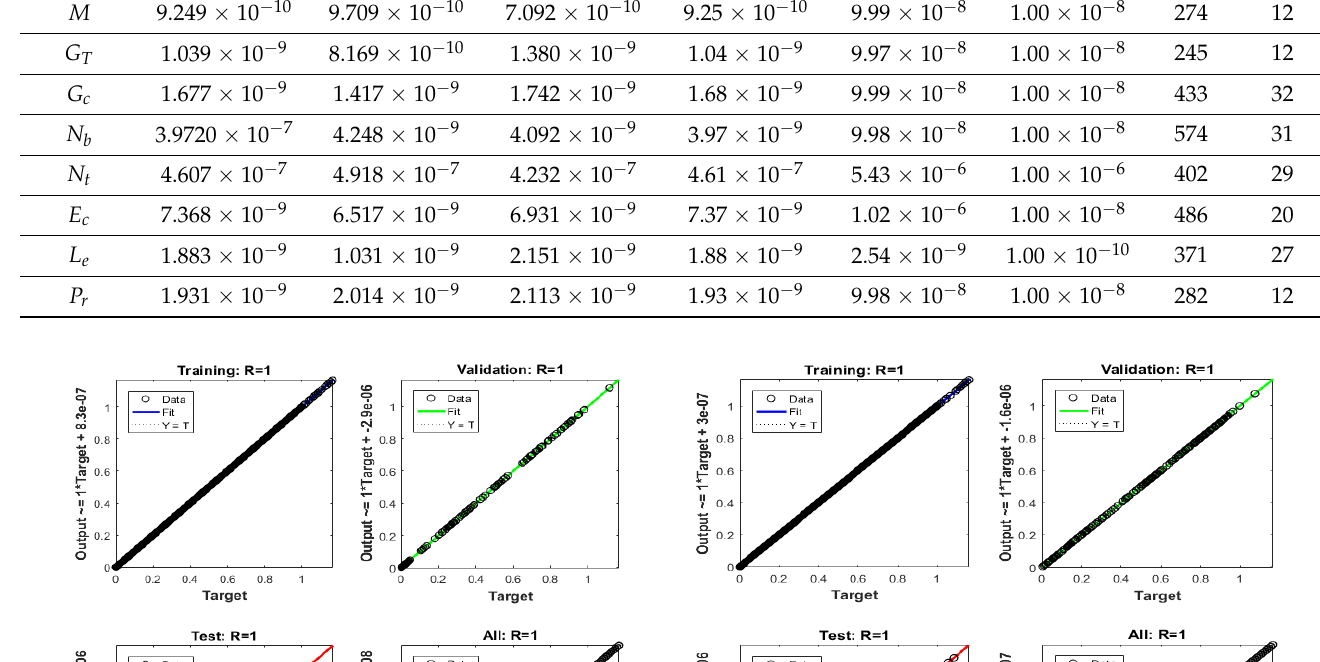
Table 3. Outcomes of TLMB-NN for eight scenarios (HTM-BFN model) with MHD. Scenarios